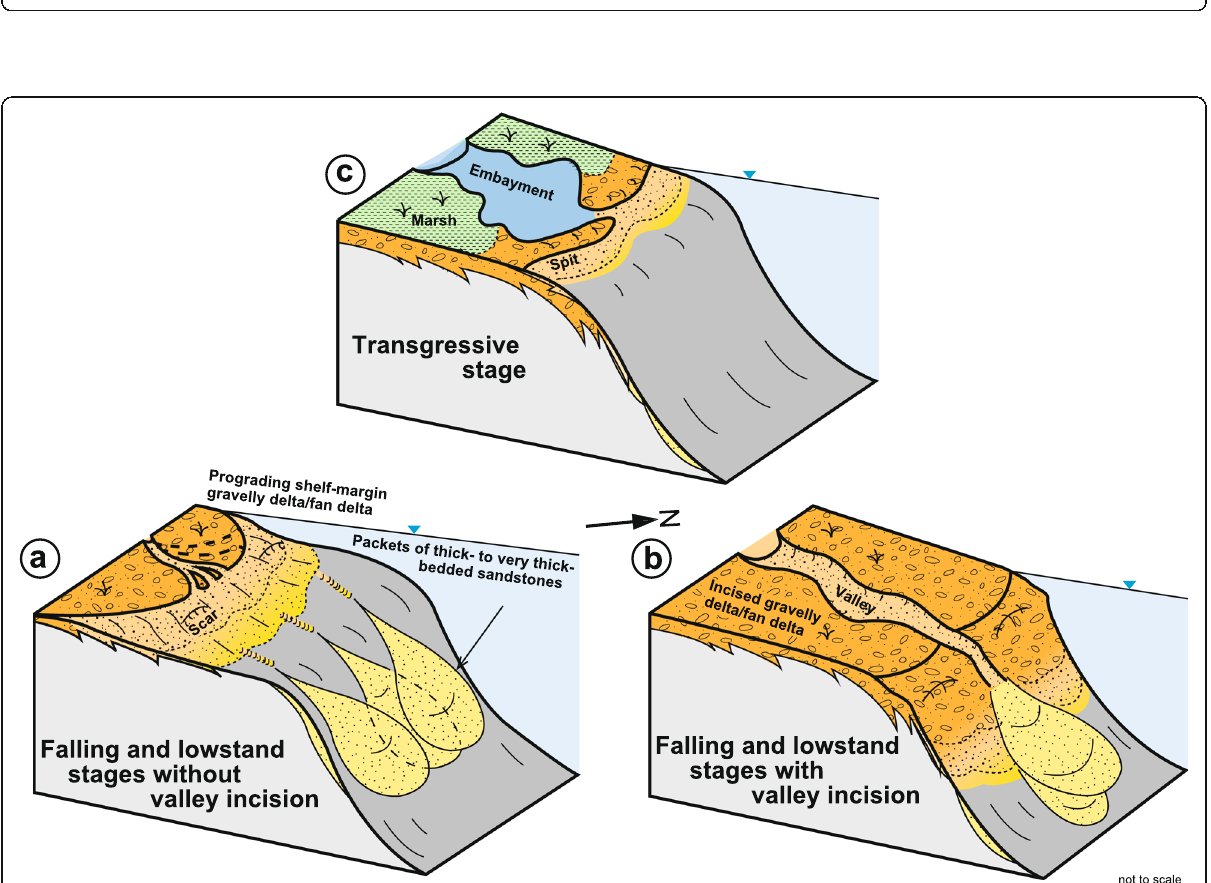
Fig. 11 Schematic illustration of temporal variations in the depositional systems in which the packets of thick- to very thick-bedded sandstones in the upper Umegase, Kokumoto, and Chonan formations